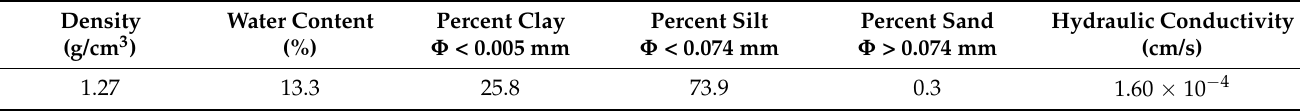
Table 1. Loess properties at the in situ experimental